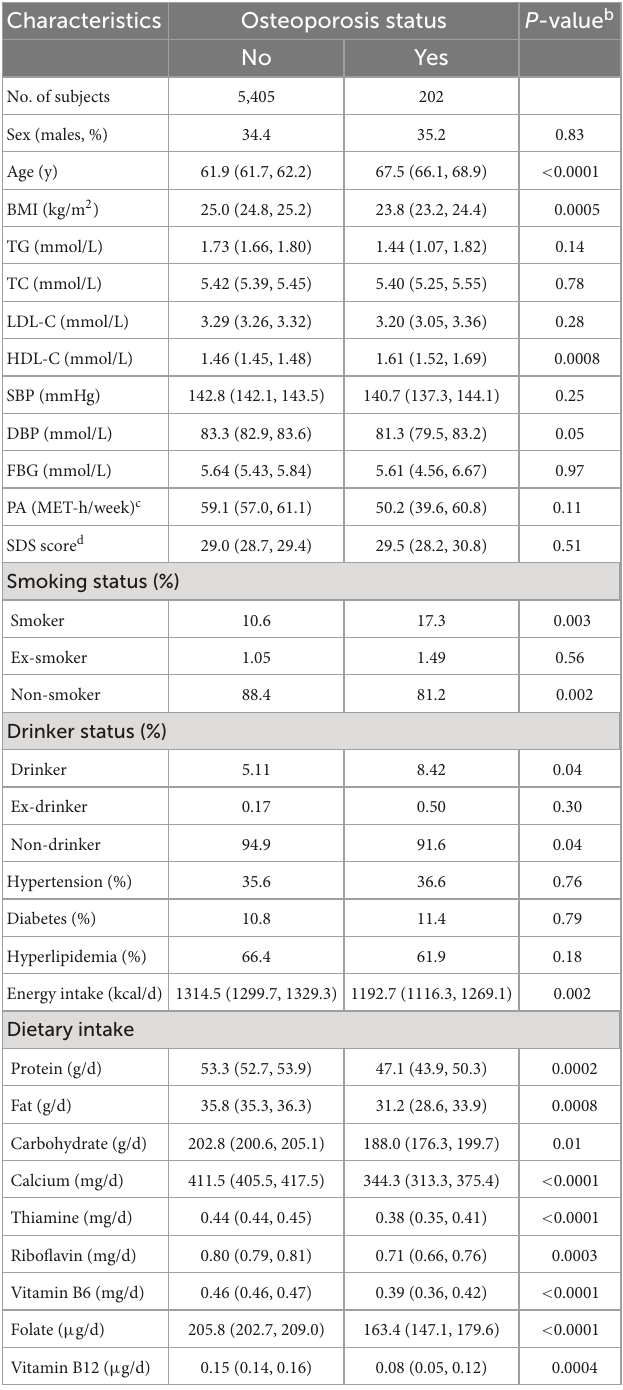
TABLE 1 Characteristics of the participants by osteoporosis status a ( n = 5,607).